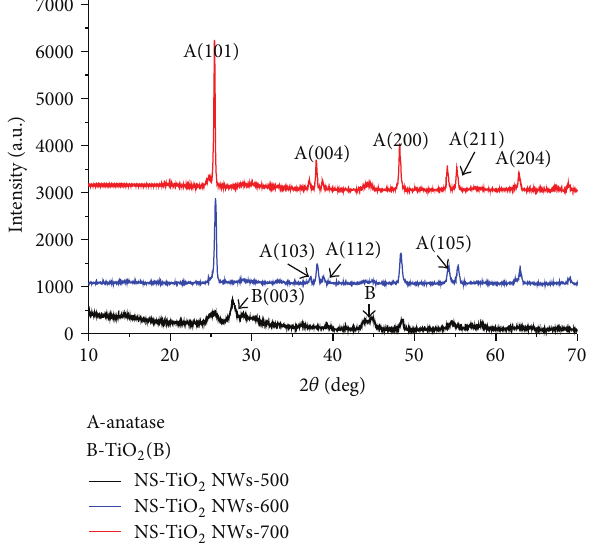
Figure 1: XRD of NS-TiO 2 NWs calcined at different temperature.